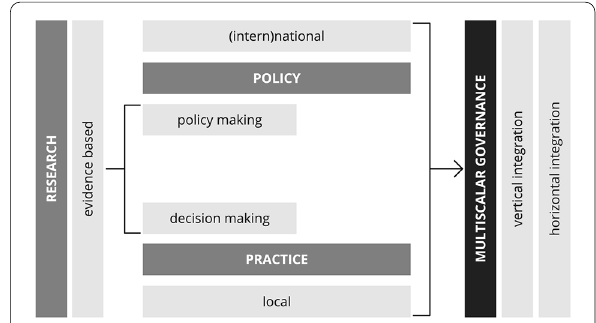
Fig. 3 Multiscalar governance for urban resilience. Source: Authors’